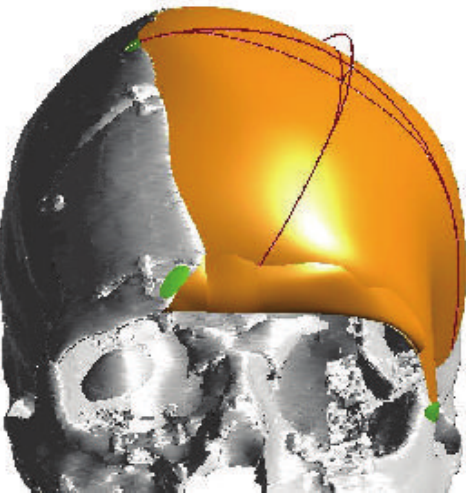
Figure 2: This figure shows a computerized reconstruction of the bony defect. This is used as a template for construction of a titanium cranioplasty prosthesis.